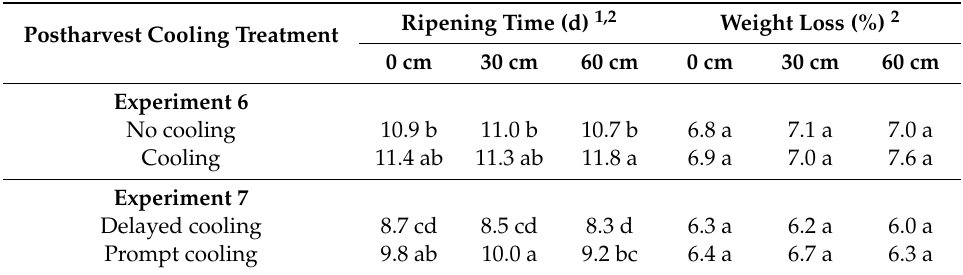
Table 6. Ripening time and weight loss of 2018 season ‘Hass’ avocado fruit from Experiments 6 and 7, subjected to drop heights of 0, 30 and 60 cm. Fruit were considered ‘ripe’ at soft-ripe stage for Experiment 6 and 1 d after firm-ripe stage for Experiment